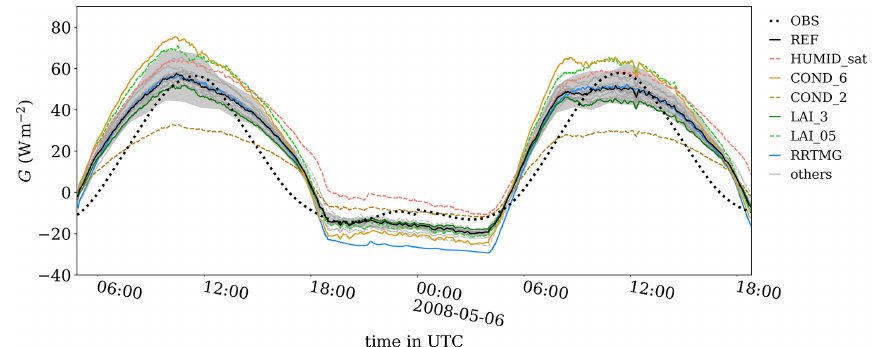
Figure 6. Time series of ground heat flux G as measured at Cabauw (OBS) and domain-averaged G for all simulated cases listed in Table 5. Only case REF and some relevant cases are highlighted; all others are shown in gray. The gray transparent area shows minimum and maximum values of the ground heat flux for case REF based on instantaneous hourly horizontal cross